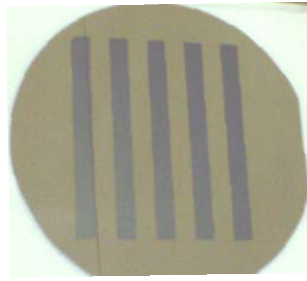
Figure 15. Photograph of DL -phenylalanine film deposited on silicon wafer (100-mm in diameter) through a 5-line pattern stencil mask.